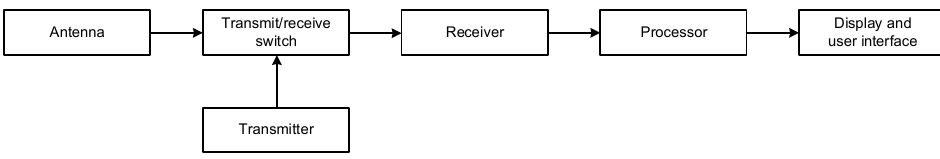
Figure 3. A general block diagram of a marine